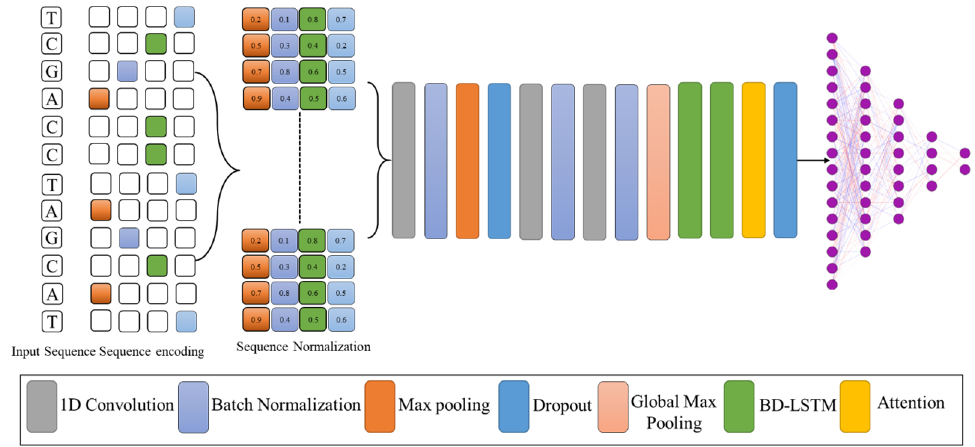
Figure 1. The proposed model for enhancer sequence classification and strength identification. Table 1. The list of notations and their descriptions used in this research work.